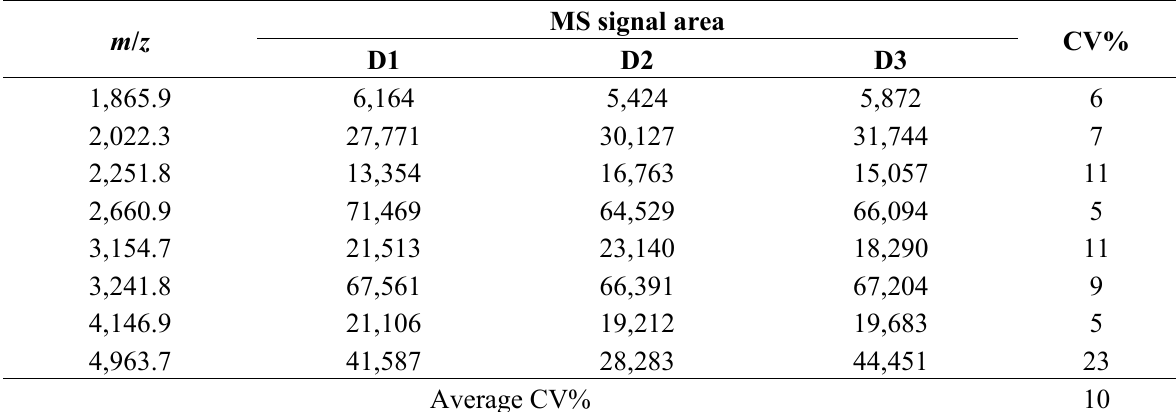
Table 3. Intra-day variability of MALDI-TOF MS after sample preparation with IMAC-Cu beads.